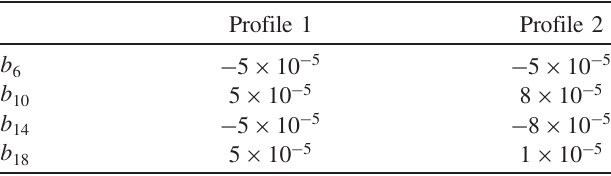
TABLE V. Systematic higher order multipoles at 7 mm radius.